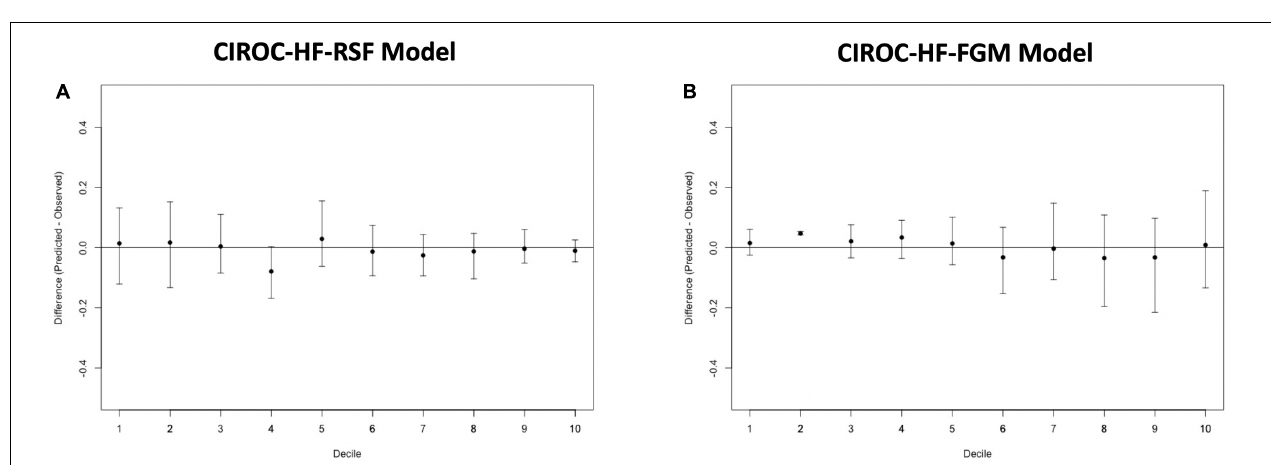
FIGURE 2 | (A) Receiver operating characteristic curves for the CIROC-HF-RSF Model, CIROC-HF-FGM Risk Model, and modified MAGGIC risk score at 90 days, 1 and 2 years follow-up in the holdout cohort. (B) Summary of CIROC-HF-RSF model, CIROC-HF-FGM Risk Model, and modified MAGGIC risk score performance in the holdout cohort.